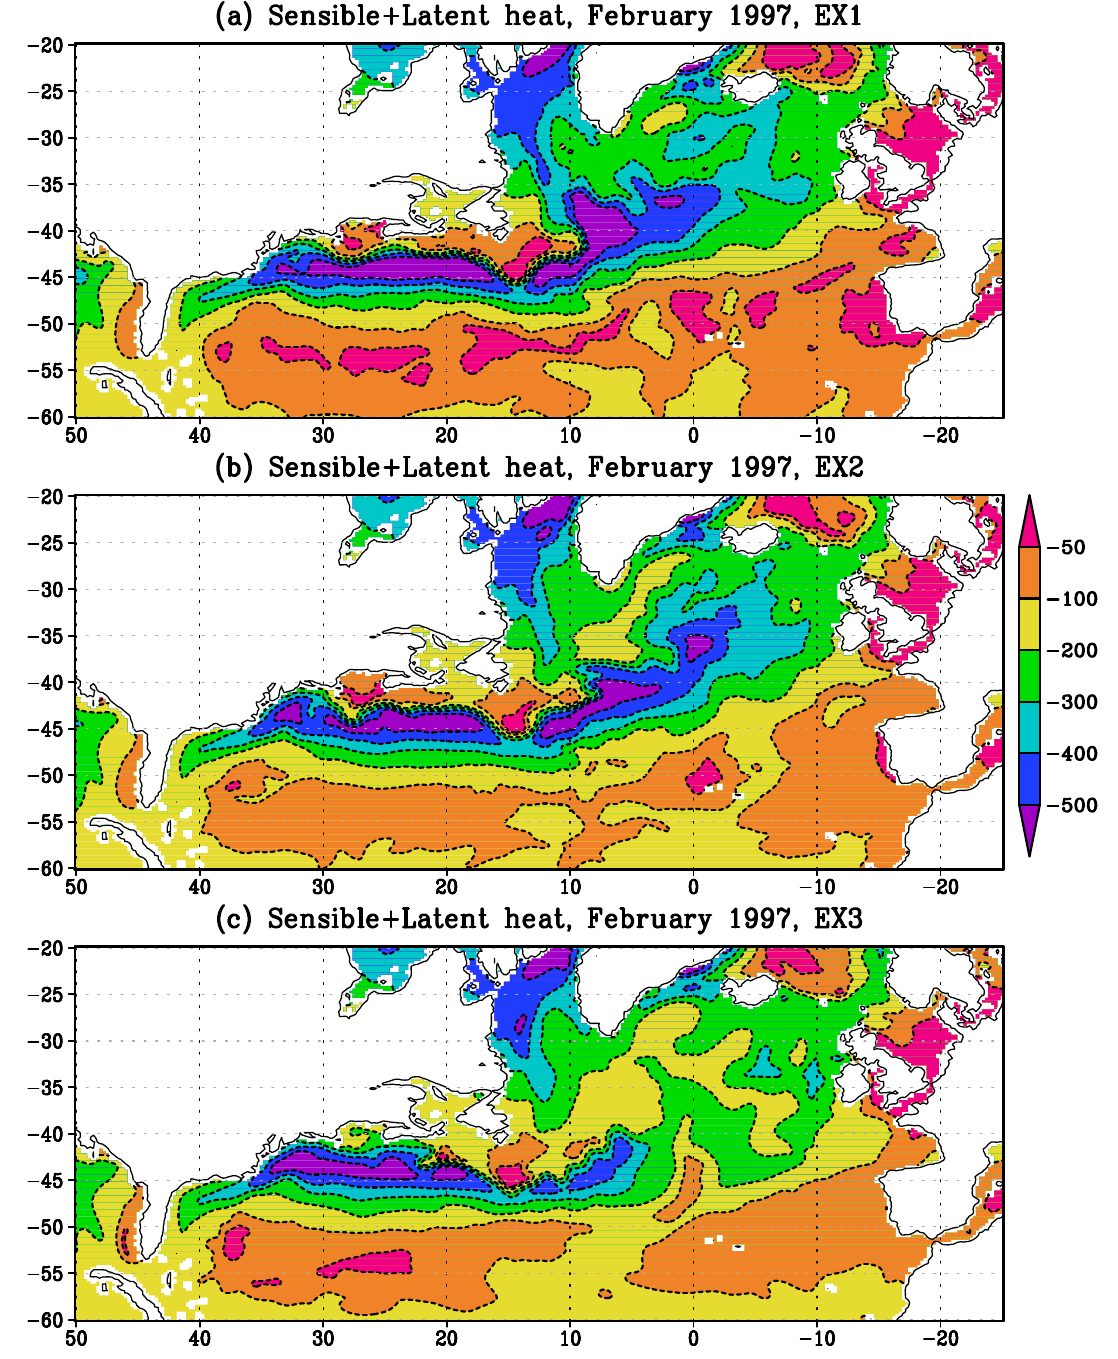
Figure 9. The sum of latent and sensible heat fluxes (W/m 2 ) at the ocean surface in February for the 50th year of the runs (1997) in the experiments EX1 ( a ), EX2 ( b ) and EX3 ( c